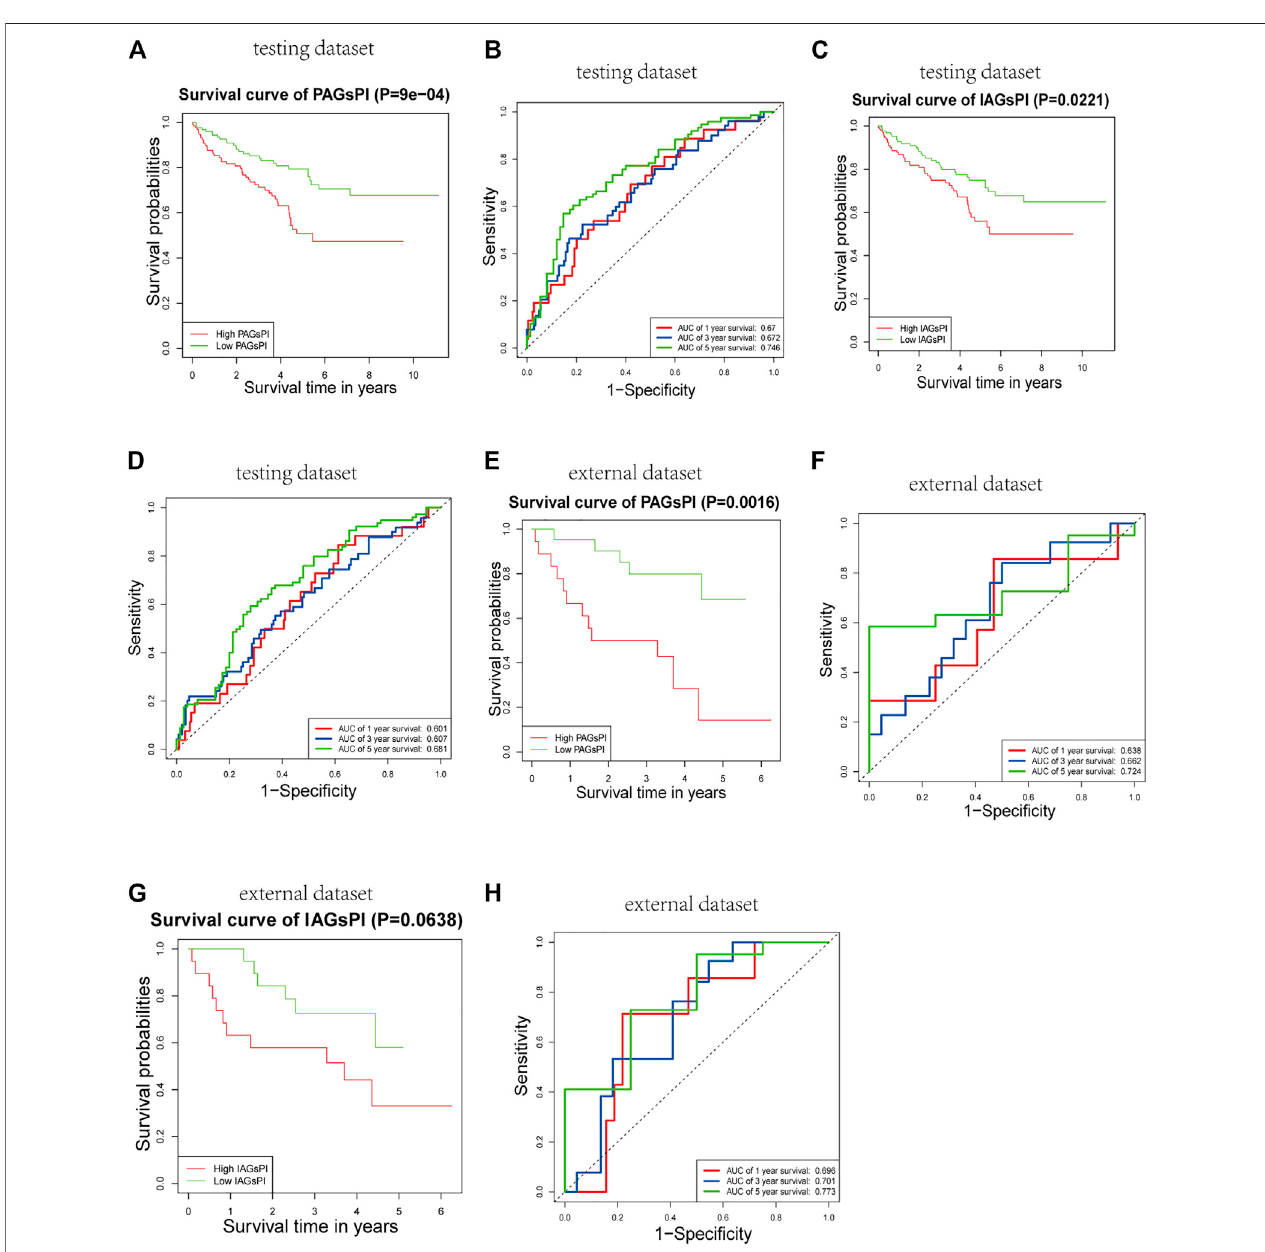
FIGURE 6 | Internal and external validation of the prognostic indices. (A,B) Results of KM survival analysis and the ROC curve for PAGsPI, in the testing dataset. (C,D) Results of KM survival analysis and the ROC curve for IAGsPI, in the testing dataset. (E,F) Results of KM survival analysis and the ROC curve of PAGsPI, in the external dataset. (G,H) Results of KM survival analysis and the ROC curve for IAGsPI, in the external